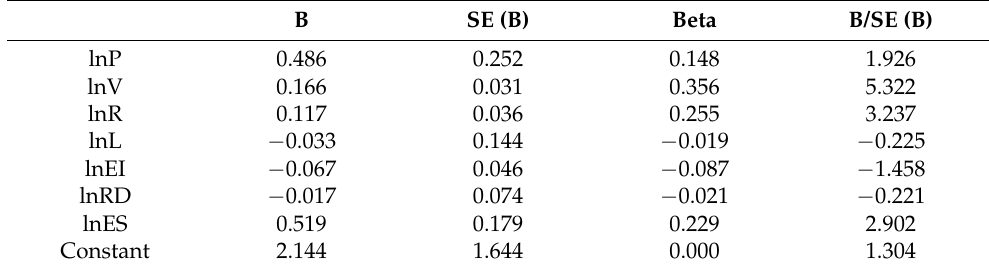
Table A2. Ridge regression fitting results.